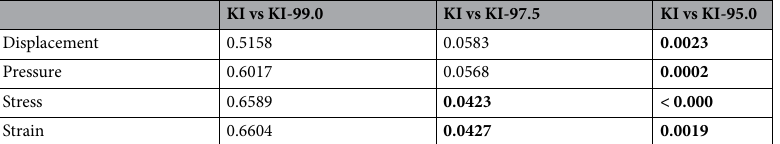
KI vs KI-99.0 KI vs KI-97.5 KI vs KI-95.0